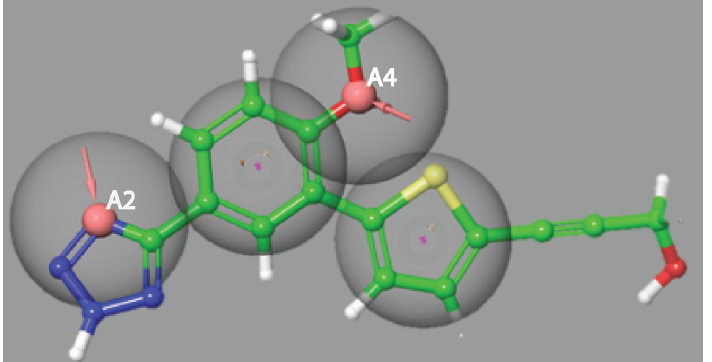
Figure 1. Pharmacophore model developed using 41 known RdRp inhibitors, with 4–5 selected pharmacophore features observed among 35 compounds. A2 (acceptor) and A4 (acceptor) are hy- drogen bond acceptors (arrows), while R9 and R11 are the aromatic rings (ring), constituting the 4- point pharmacophore presented over the reference ligand 68T inhibitor. Table 1. Physicochemical properties of the 41 compounds used for building the pharmacophore model. S. No. PubChem ID HBA HBD Molecular Mass Number of Rings Aromatic Bonds